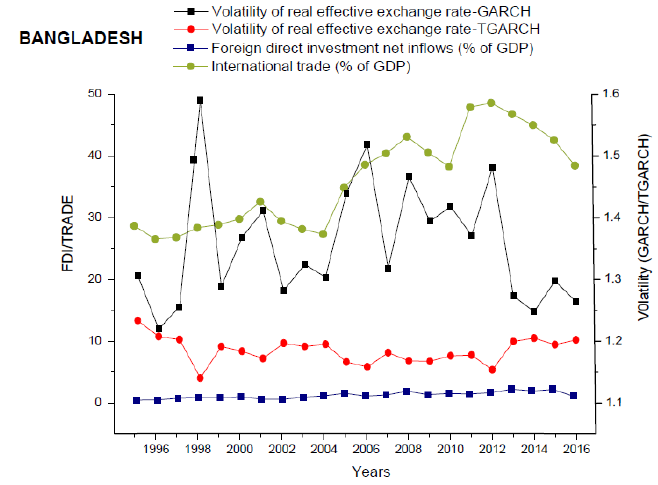
Figure 1. Exchange Rate Volatility vs. FDI/Trade (Bangladesh).